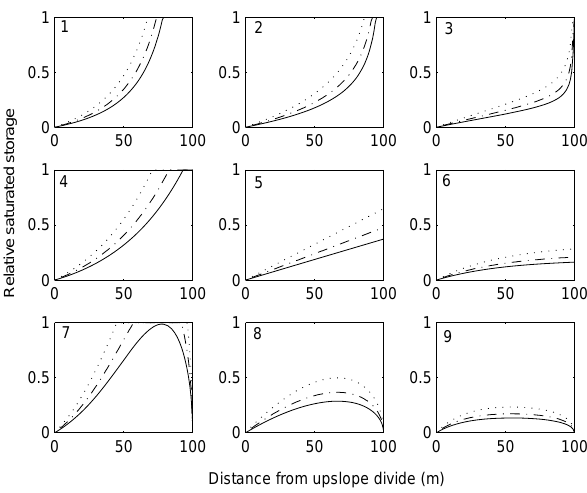
Fig. 8. Relative saturated storage along the nine basic hillslopes for different bottom average bedrock slope angles (solid line: β =25, ω =0.0047 dashed line: β =20, ω =0.0036; dotted line: β =15, ω